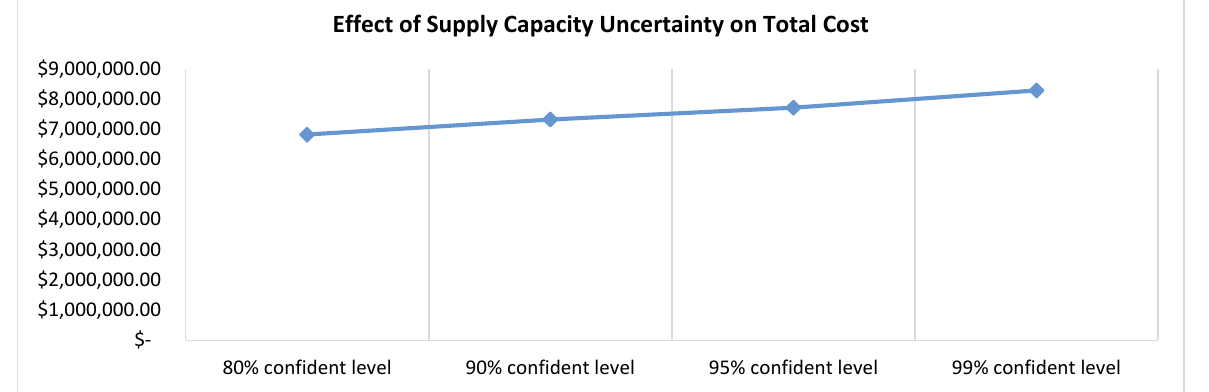
Fig. 6. Effect of Supply CapacityUncertainty on Total Cost